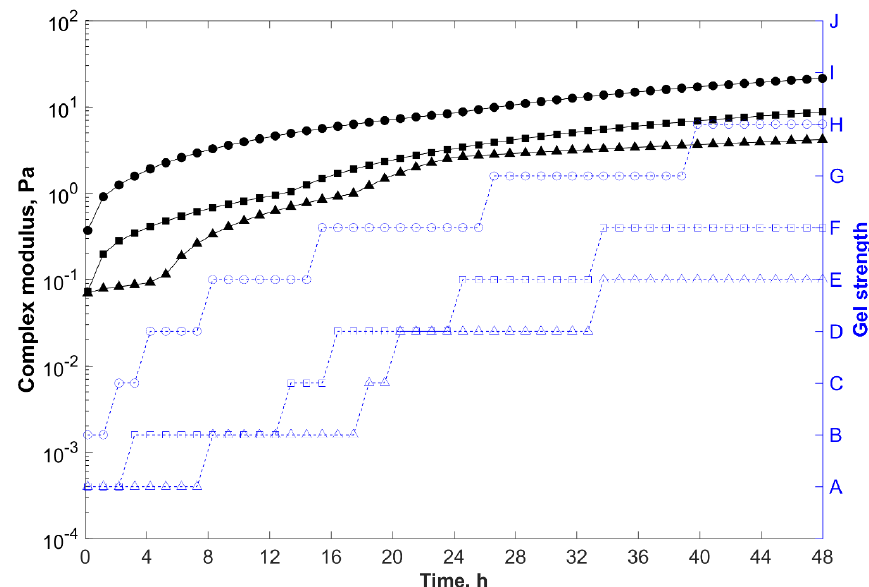
Figure 3. Complex modulus ( ─ ) and gel strength (- -) versus time for samples prepared in field water at 85 °C, with 0.8 wt % of clay, 0.5 wt % of PEI, and different polymer concentrations. , 0.2 wt % (F1); , 0.6 wt % (F4); and , 1.0 wt % (F7). Figure 8. Complex modulus ( ─ ) and gel strength (- -) versus time for samples prepared at 85 °C, with 0.6 wt % polymer, 0.5 wt % PEI, and 0.8 wt % clay (F4), in water with different total dissolved solids (TDS).